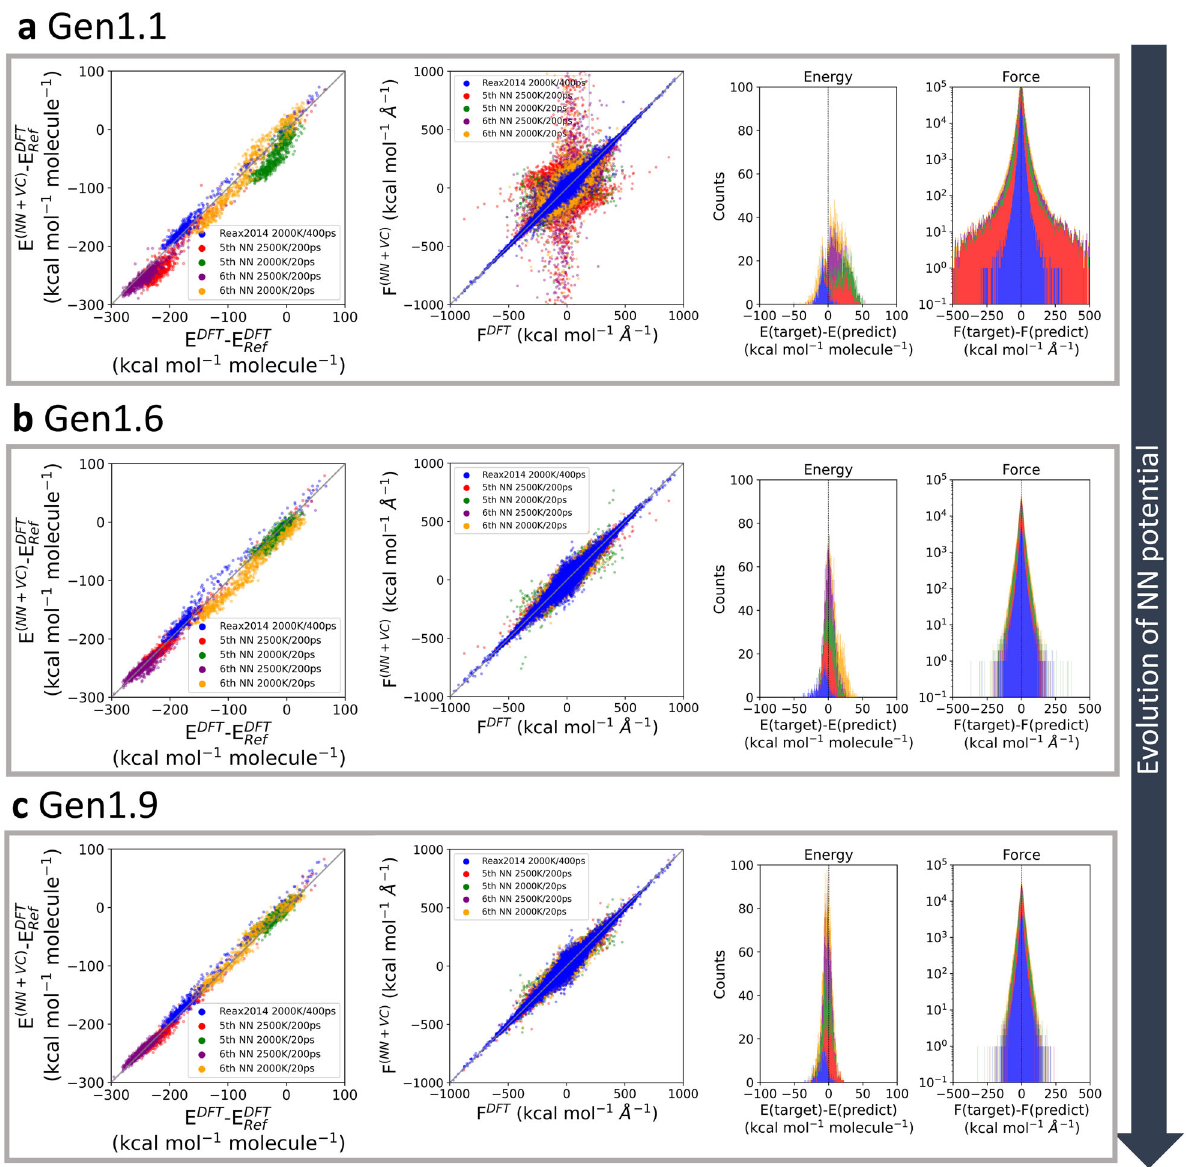
Fig. 2 The parity plot and the stacked histogram of the energy and forces of test sets. The decrease of energy (the right panel) and force (the middle panel) RMS errors monitored over several iterations in a Gen1.1, b Gen1.6, and c Gen1.9 NNRF. The left panels show the histogram counting the energy and force